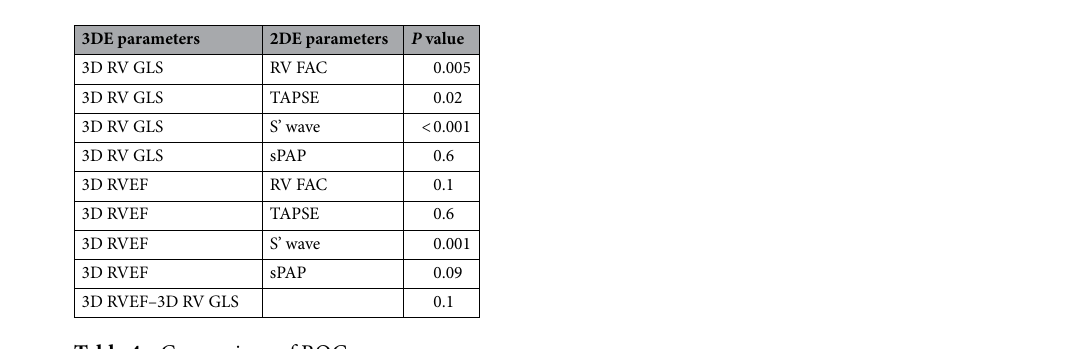
Table 4. Comparison of ROC curves.